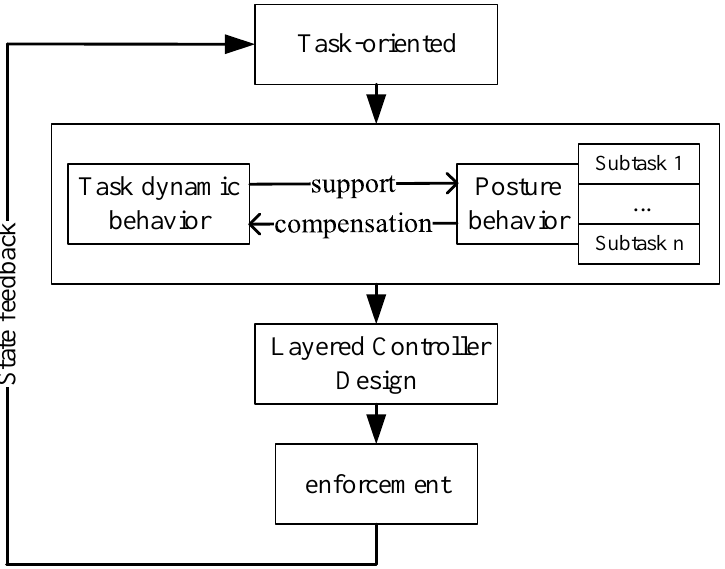
Figure 6. Schematic diagram of the whole-body controller.